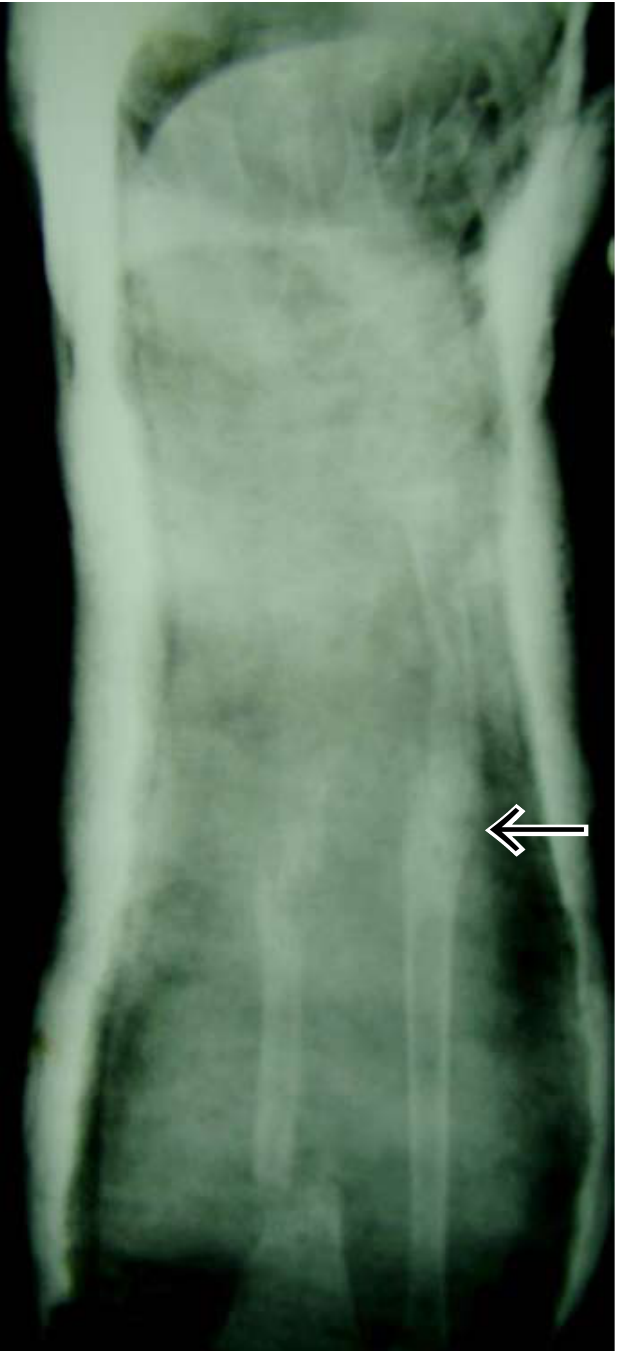
Fig. 13a. Patient with NF1 presenting with radial fractures. Note also pseudo- arthrosis of the ulna.